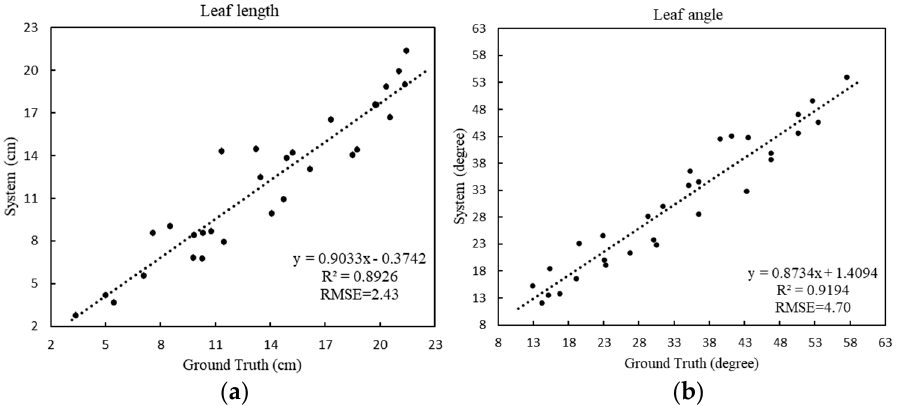
Figure 8. Regression analyses comparing actual leaf length versus estimated leaf length ( a ), and actual leaf angle versus estimated leaf angle ( b ).